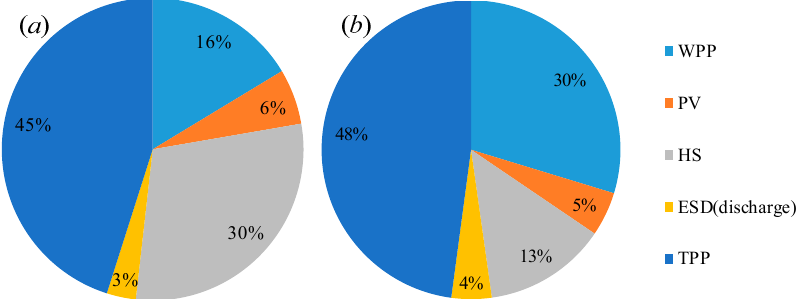
Figure 12. The power output structure of MECS scheduling under the OEE mode: ( a ) summer and ( b ) winter.